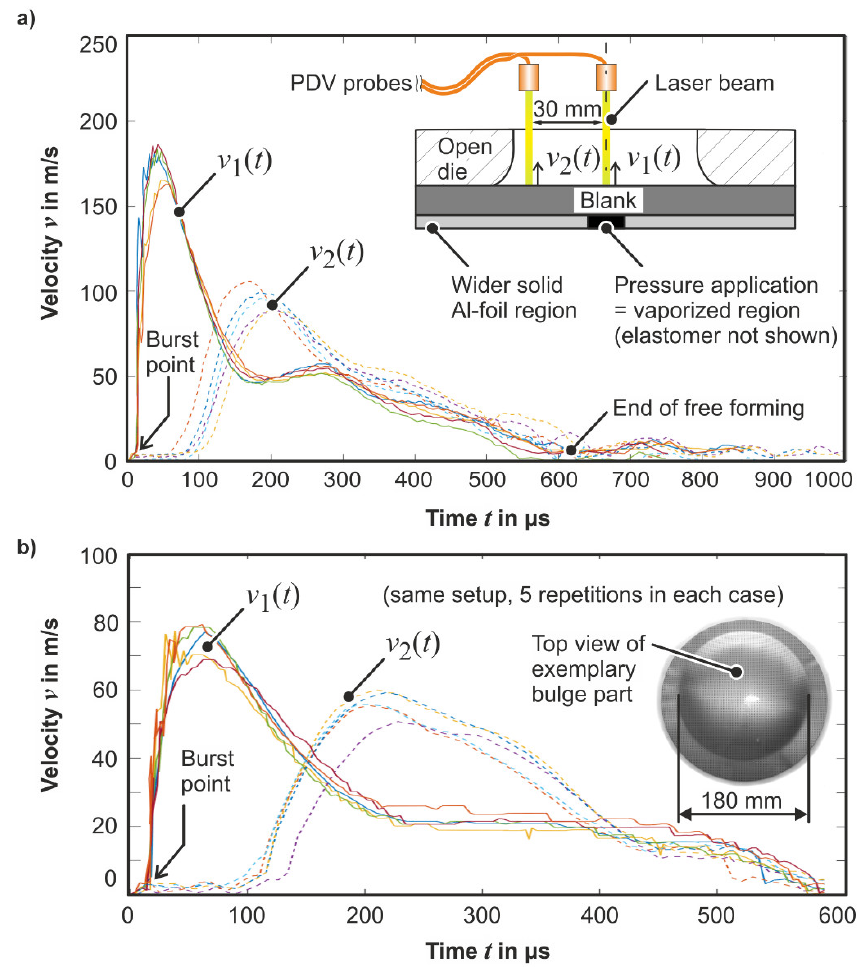
Figure 3. Selected experimental free forming results: ( a ) 10 kJ charging energy (giving an energy density of 18 MJ/kg in the burst region), ( b ) 6 kJ charging energy (13.5 MJ/kg).